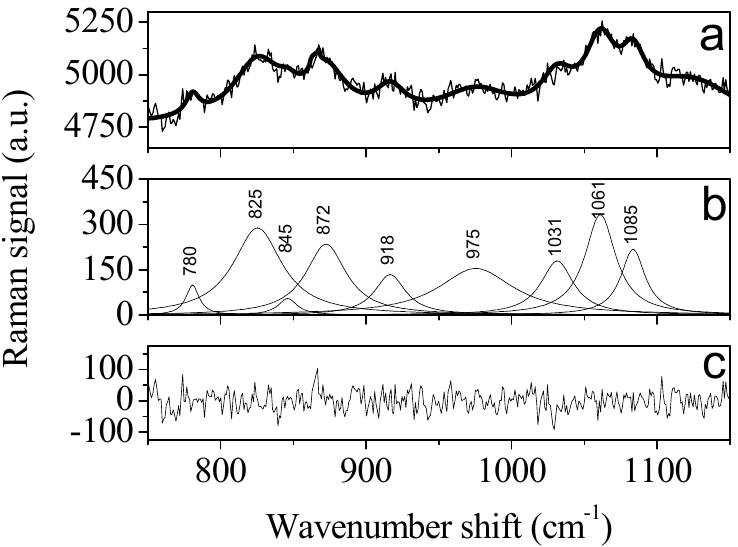
Figure 2 . Deconvolution procedure on the spectrum reported in Figure 1 in the wavenumber range 700-1200 cm -1 . The continuous upper curve ( a ) represents the best fit using the components shown in the frame ( b ) . The curve in ( c ) represents the residual errors for the fit (see the scale on the